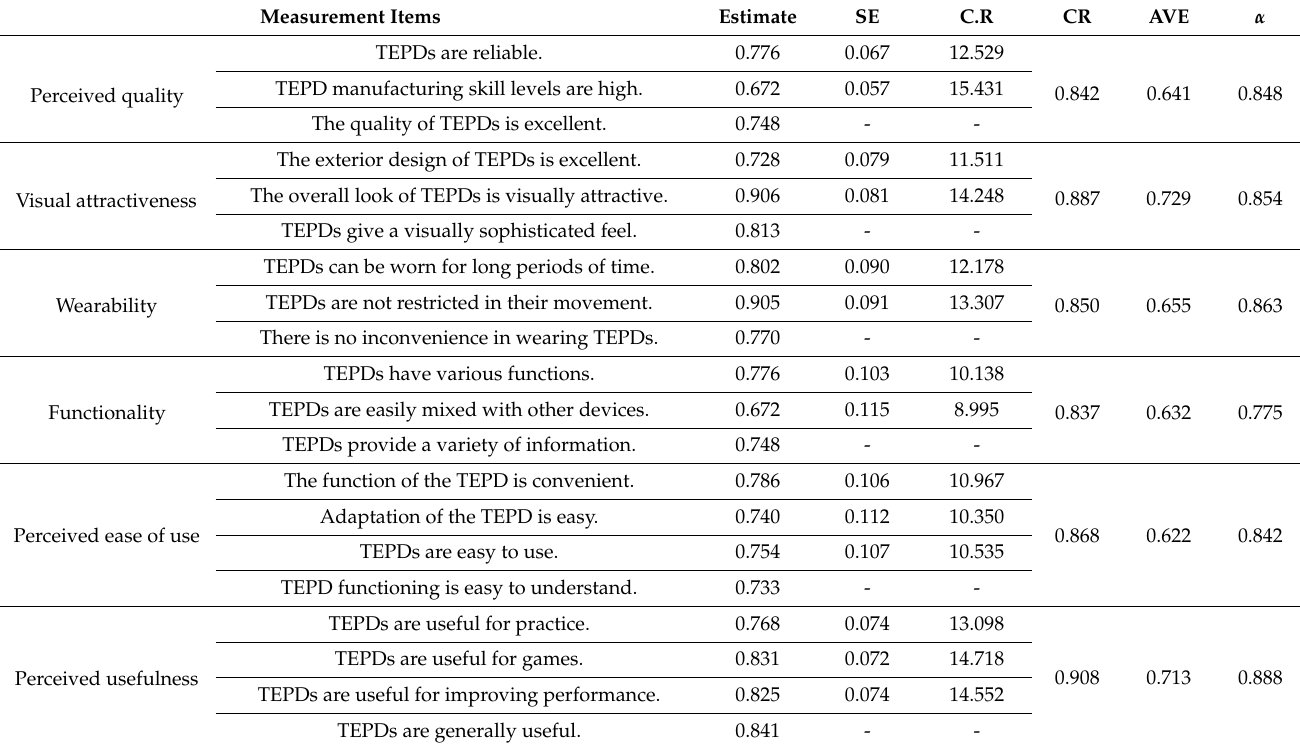
Table 2. Validity and reliability of research